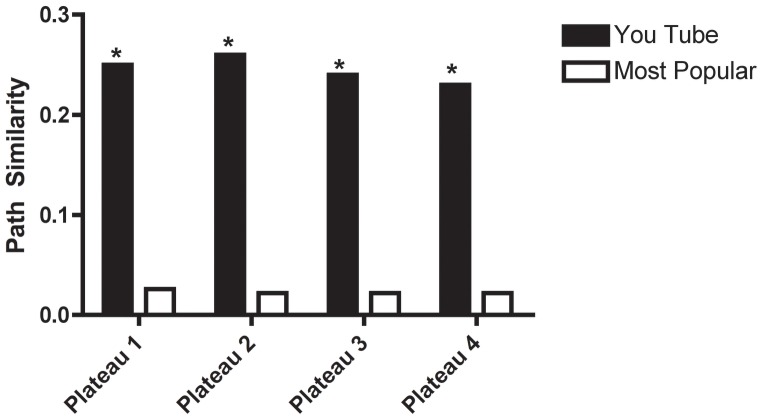
Semantic similarity of YouTube comments to established signs and symptoms of dextromethorphan use.The black bars refer to “Robo-tripping” videos from YouTube, the white bars to the most popular videos (see sec:Methods). All values for path similarity are calculated relative to the signs and symptoms mentioned in [25].